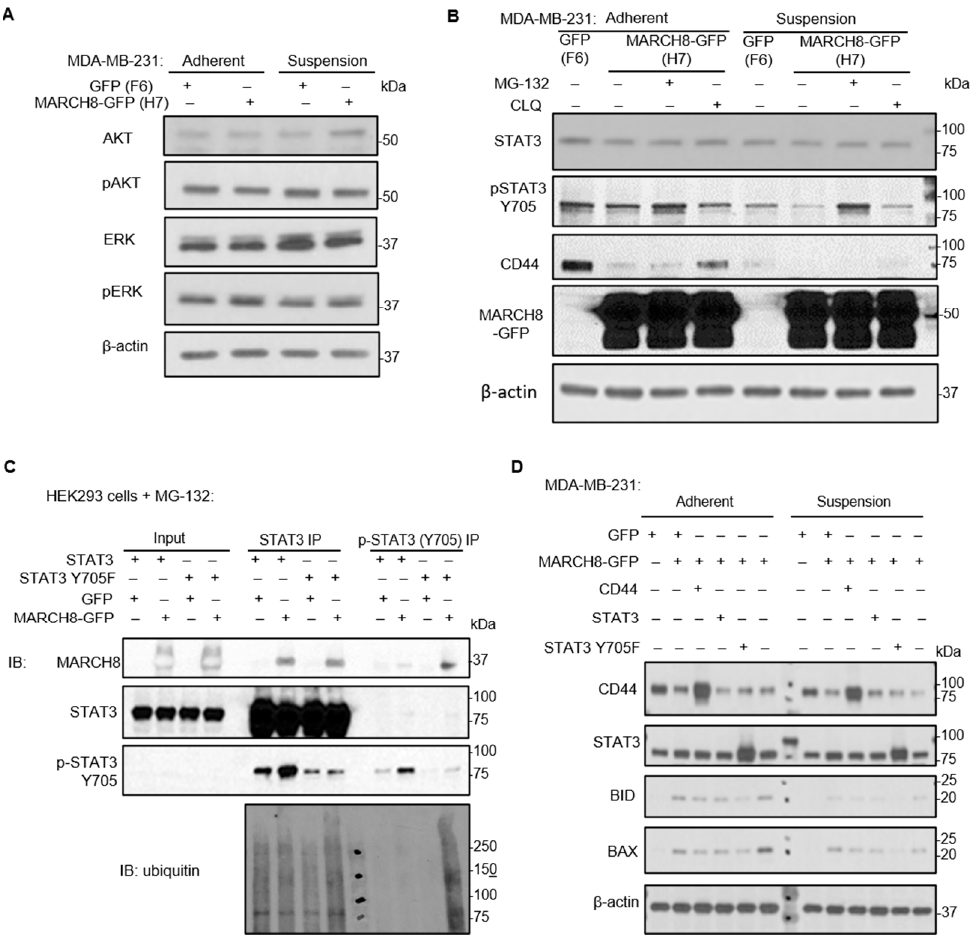
Figure 6. MARCH8 interacts with and degrades STAT3 through the proteasome pathway. ( A ) Immunoblots of AKT, pAKT, ERK, and pERK in MDA-MB-231 cells with stable expression of GFP and MARCH8-GFP, both adherent and in suspension. ( B ) Immunoblots of STAT3, pSTAT3 (Y705), CD44, and MARCH8 in GFP- and MARCH8-GFP-expressing cells in the absence or presence of MG-132 and CLQ, both adherent and in suspension. ( C ) Immunoblots of MARCH8, STAT3, pSTAT3 (Y705), and ubiquitin in lysates of cells co-transfected with STAT3 (wildtype or Y705F) and MARCH8-GFP (or GFP control) and immunoprecipitated by anti-STAT3 and anti-pSTAT3 (Y705). ( D ) Immunoblots of CD44, STAT3, BID, and BAX in MDA-MB-231 cells with stable expression of GFP and MARCH8-GFP, with transient transfection with CD44, STAT3, or mutant Y705F as indicated, both adherent and in suspension.